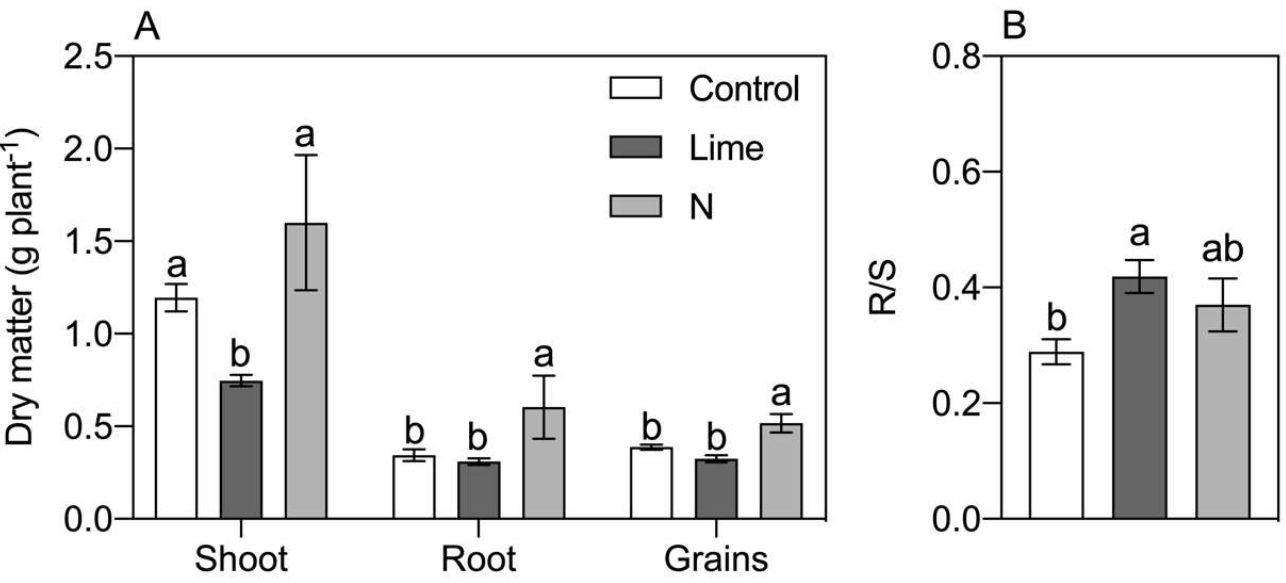
Figure 3. ( A ) Dry matter of shoots, roots and grains produced by lentils grown in pots that were harvested 157 days after sowing and ( B ) root to shoot ratio (R/S). Small letters indicate significant differences among treatments after Tukey’s test ( p < 0.05).